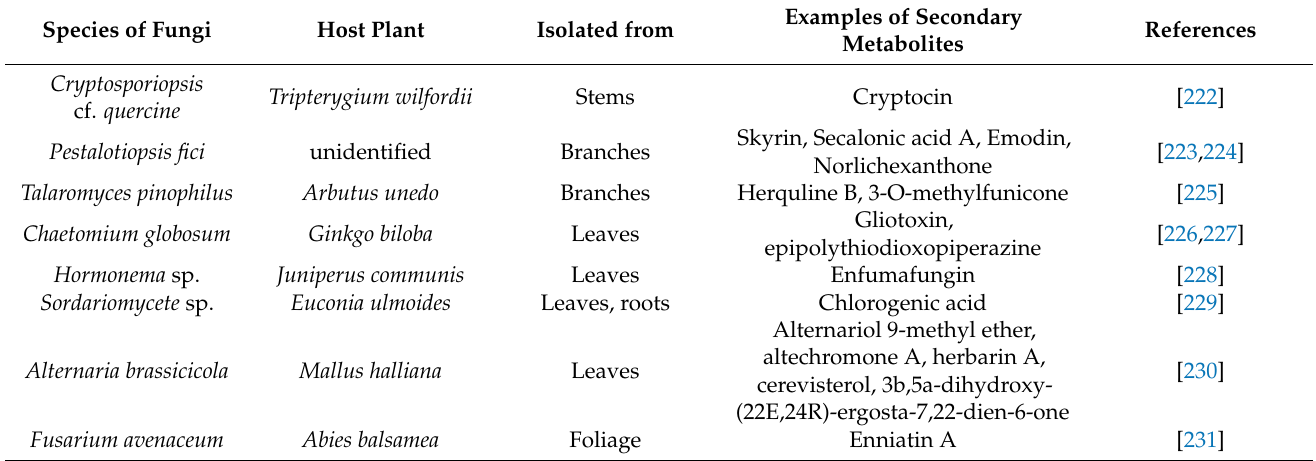
Table 3. The examples of secondary metabolites produced by